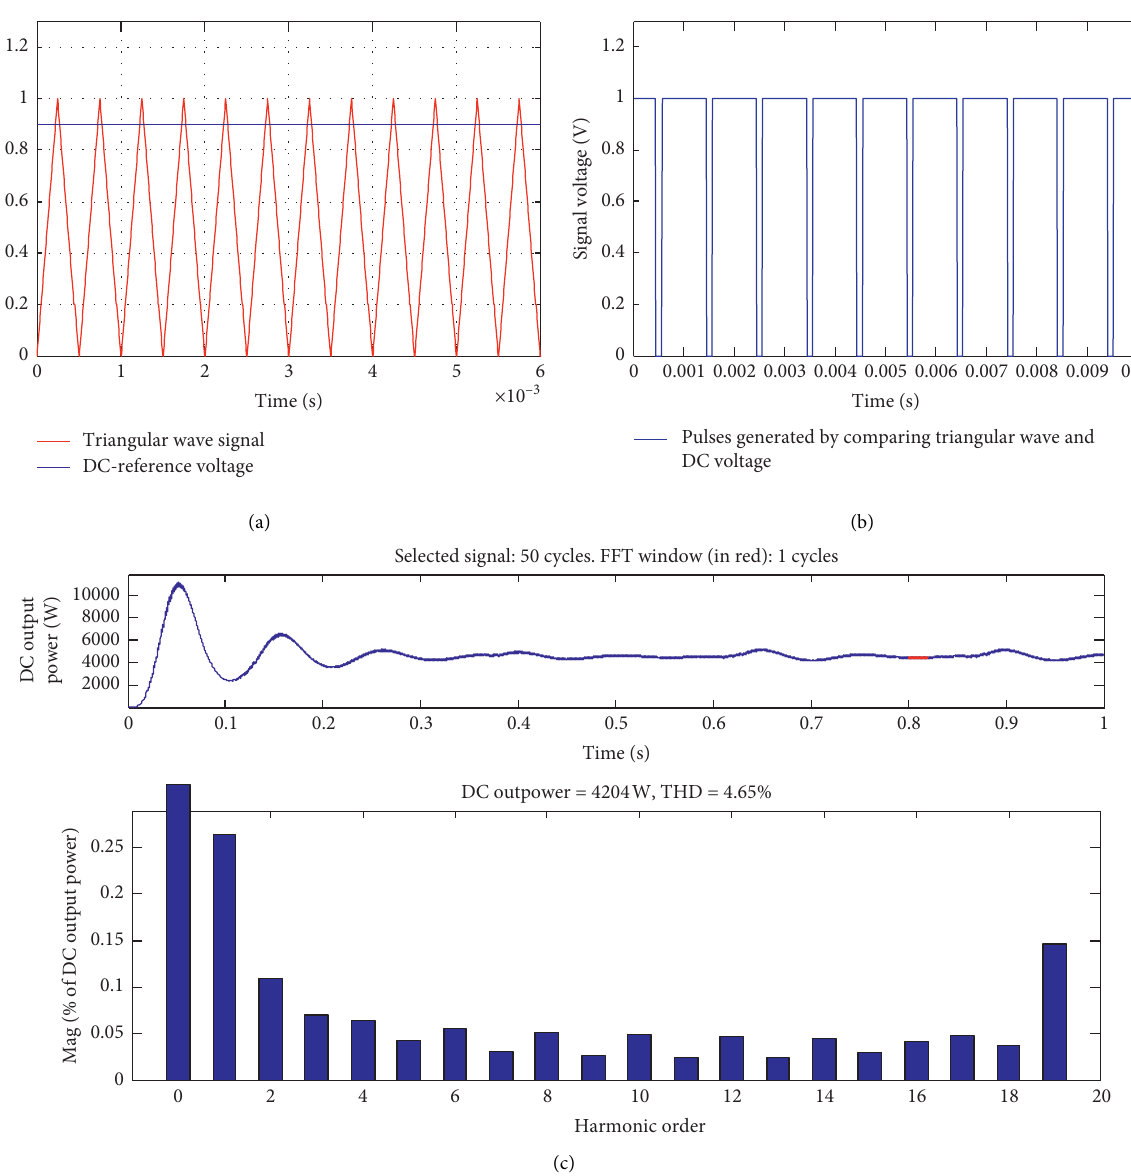
Figure 4: (a) DCVTBM. (b) Firing pulses of ZPCSMS. (c) Spectral analysis of the output power of boost DC-DC converter using